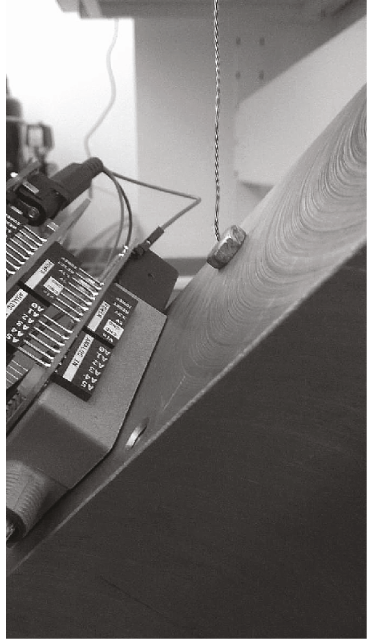
Figure 4: Detailed view of the suspension